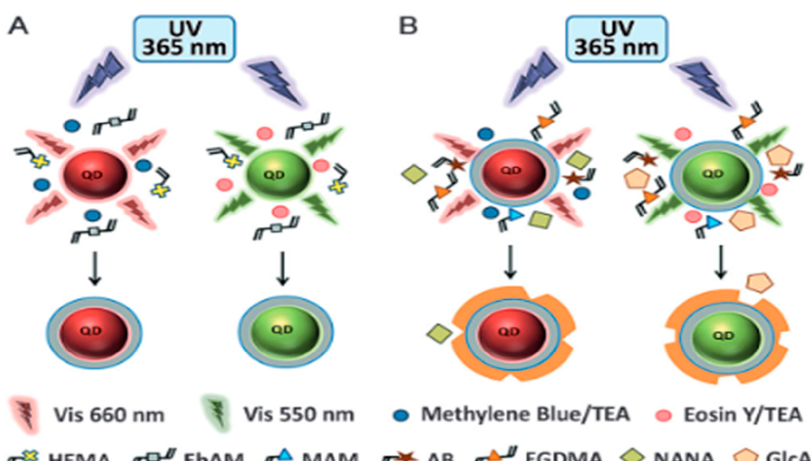
Figure 10. ( A ) Red or green light emitted from InP/ZnS quantum dots excited by UV irradiation is used to synthesize a polymeric shell in situ around the particles by photopolymerization. Methylene blue/triethyl-amine (TEA) are used as the initiator system for red-QDs and eosin Y/TEA for green- QDs. ( B ) A second shell of MIP is synthesized by reinitiation in the presence of functional and cross-linking monomers and a molecular template (GlcA or NANA). Reproduced with permission from [87] Copyright 2016 John Wiley & Sons .